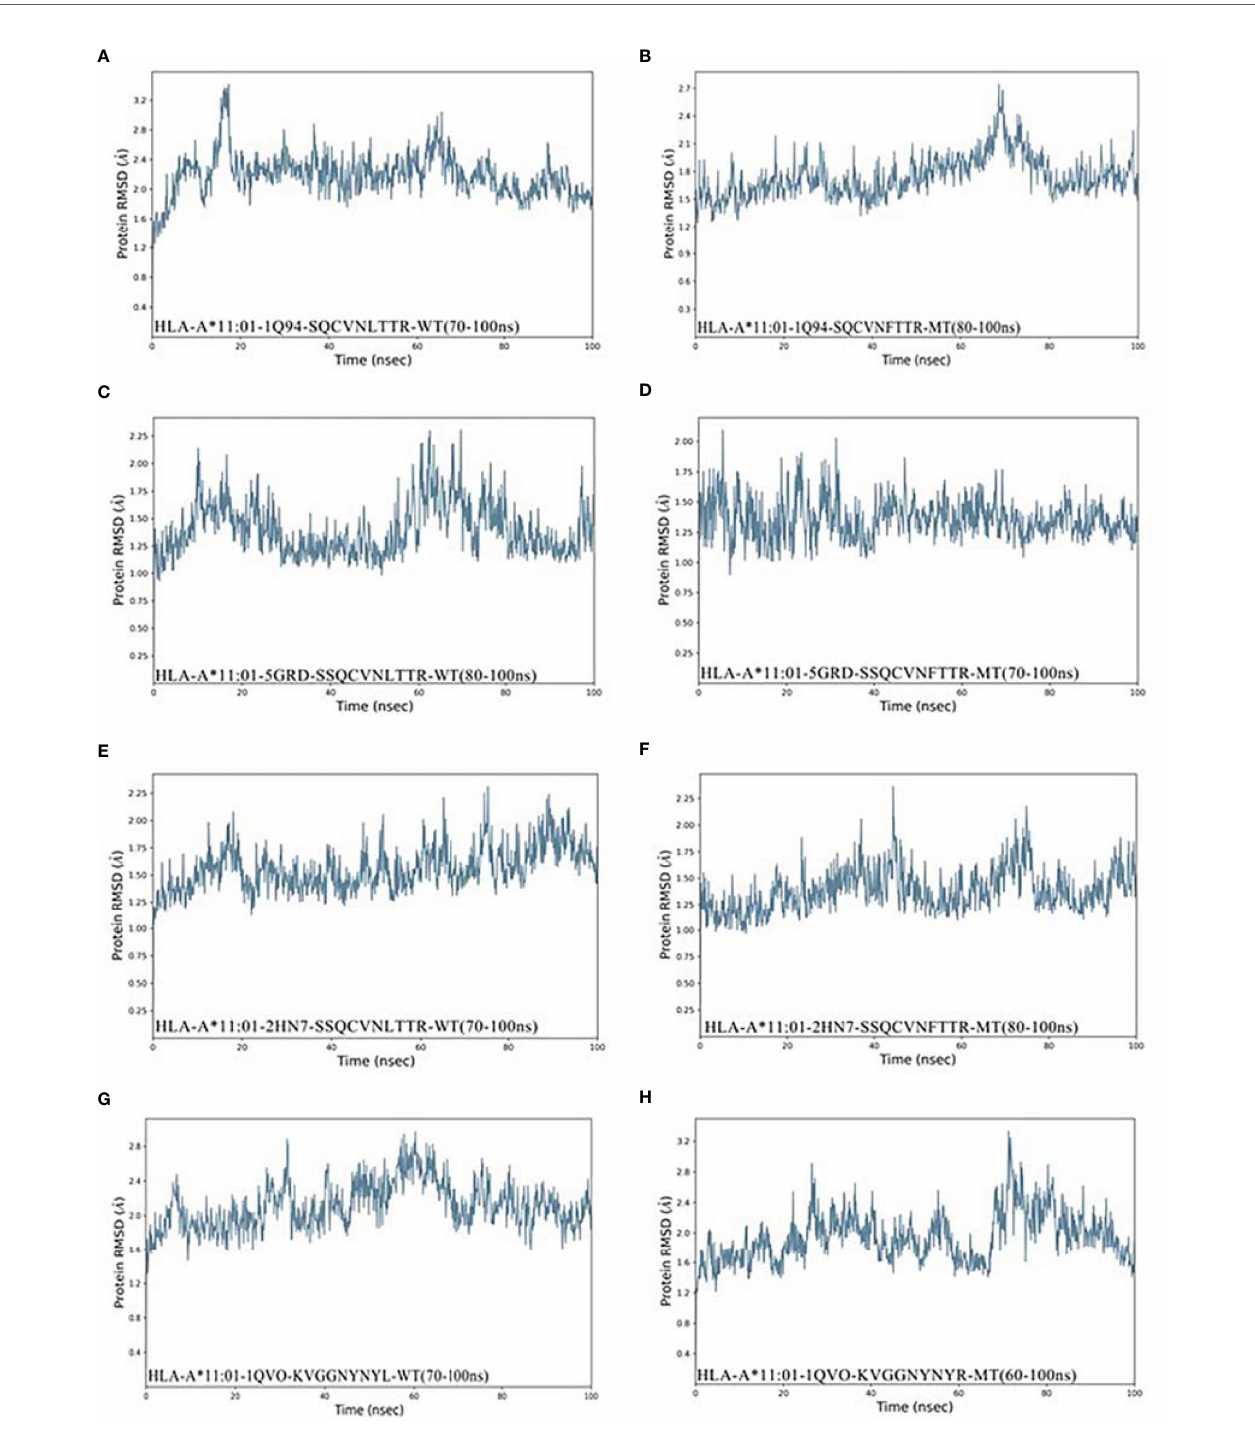
FIGURE 3 | RMSD plot of the HLA-A*11:01-epitopes, indicating stability. (A) HLA-A*11:01(1Q94)-SQCVNLTTR (WT). (B) HLA-A*11:01(1Q94)-SQCVNFTTR (MT). (C) HLA-A*11:01(5GRD)-SQCVNLTTR (WT). (D) HLA-A*11:01(5GRD)-SQCVNFTTR (MT). (E) HLA-A*11:01(2HN7)-SSQCVNLTTR (WT). (F) HLA-A*11:01(2HN7)- SSQCVNFTTR (MT). (G) HLA-A*11:01(1QVO)-KVGGNYNYL (WT). (H) HLA-A*11:01(1QVO)-KVGGNYNYR (MT). RMSD, root mean square deviation; MT, mutation type; WT, wild